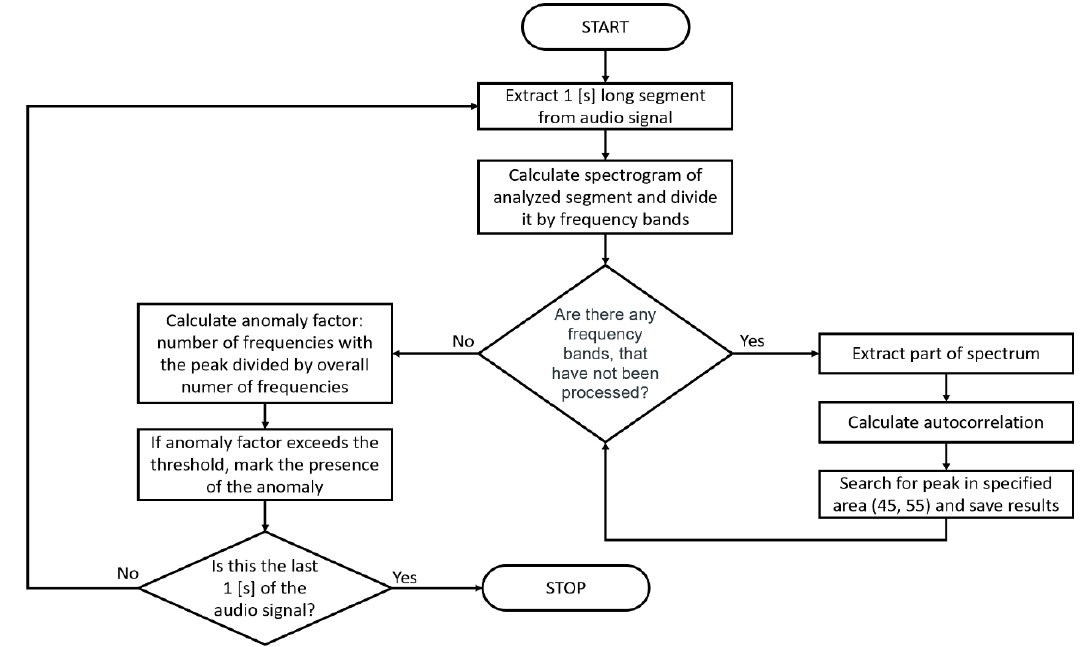
Figure 3. Scheme of algorithm for detection of incorrect operation of the idler set.